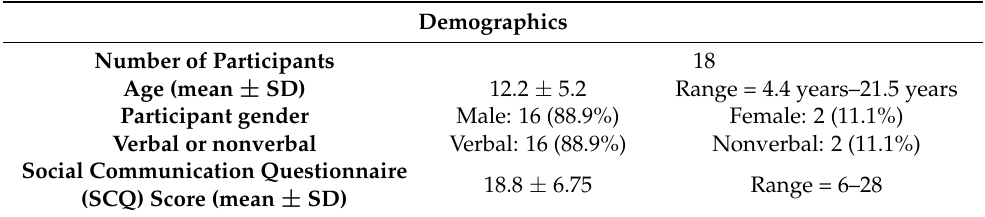
Table 2. Demographics of Study